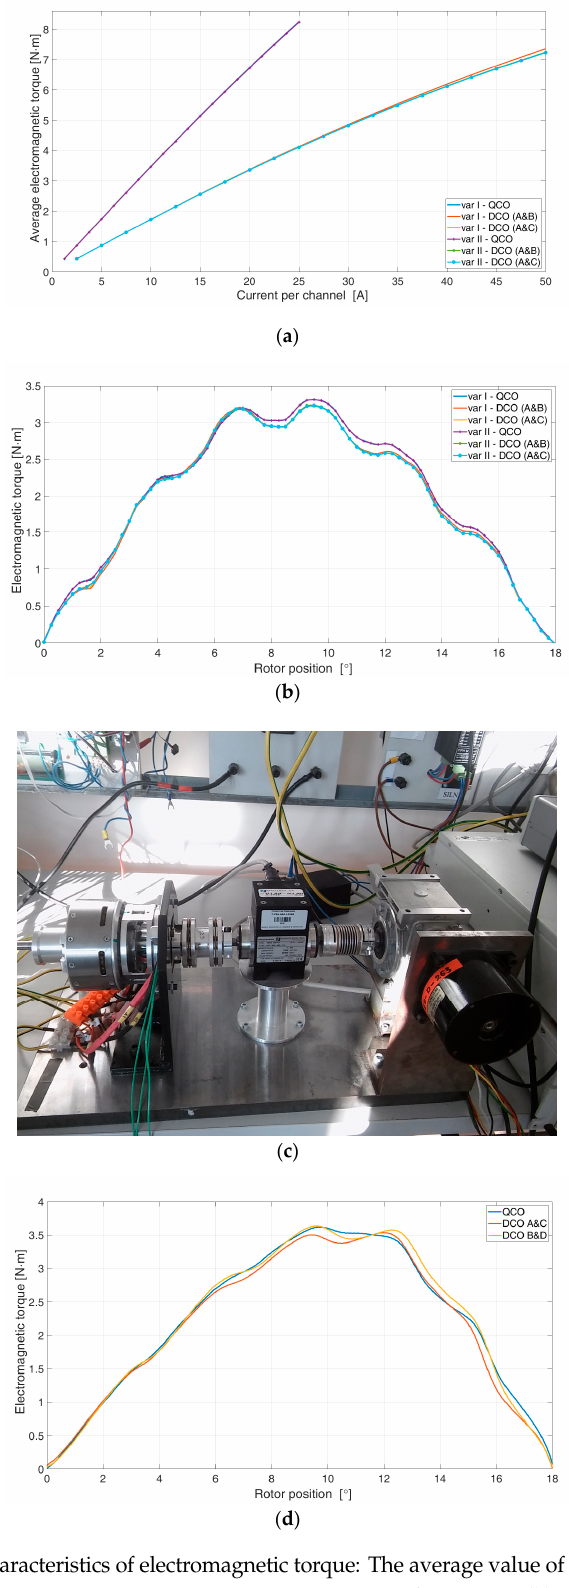
Figure 4. The static characteristics of electromagnetic torque: The average value of electromagnetic torque vs. current ( a ); electromagnetic torque vs. rotor positions—simulation tests ( b ); the stand to determine static characteristics ( c ); electromagnetic torque vs. rotor positions (laboratory test—variant II) ( d